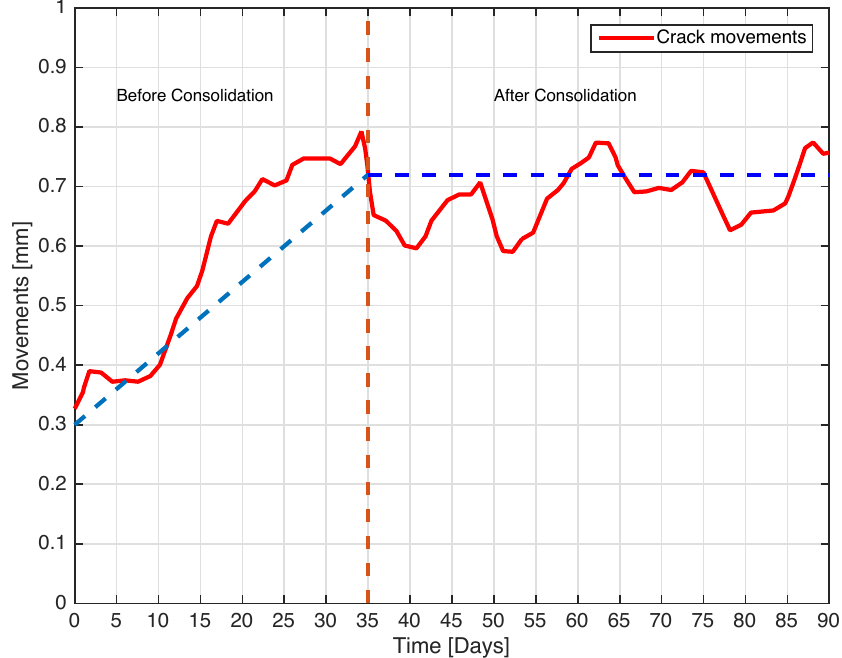
Figure 16. Crack movements vs. time. The tag placed on position B in the north side of the building, before and after the consolidation.